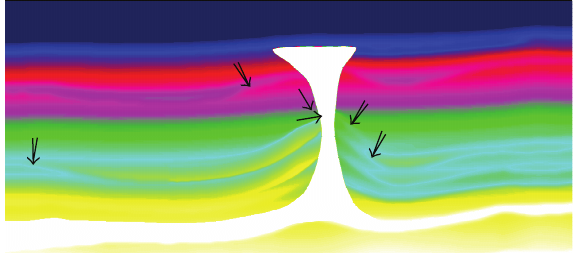
Figure 1: Part of BP anisotropic velocity model that contains a salt body. The abrupt change in velocity magnitude can be interpreted as reflections, and the arrows point to examples of the possible directions of TI symmetry tilt to accommodate a DTI